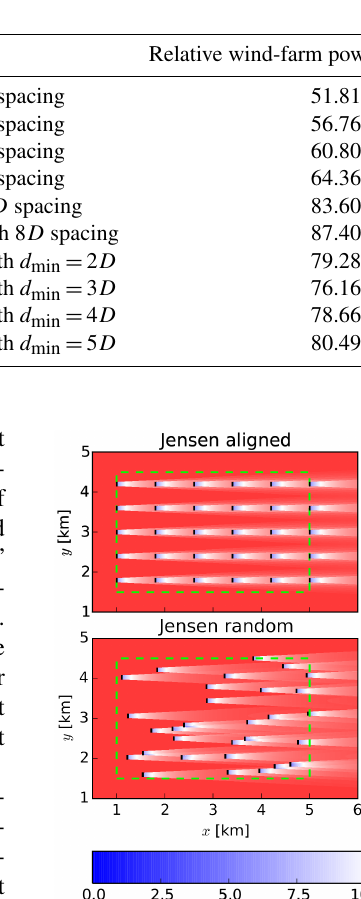
Table 2. Large-eddy simulation results for different wind-farm layouts. Power output normalised with respect to total power of a wind-farm consisting of “first-row” turbines. Average LES power is 69.97%.